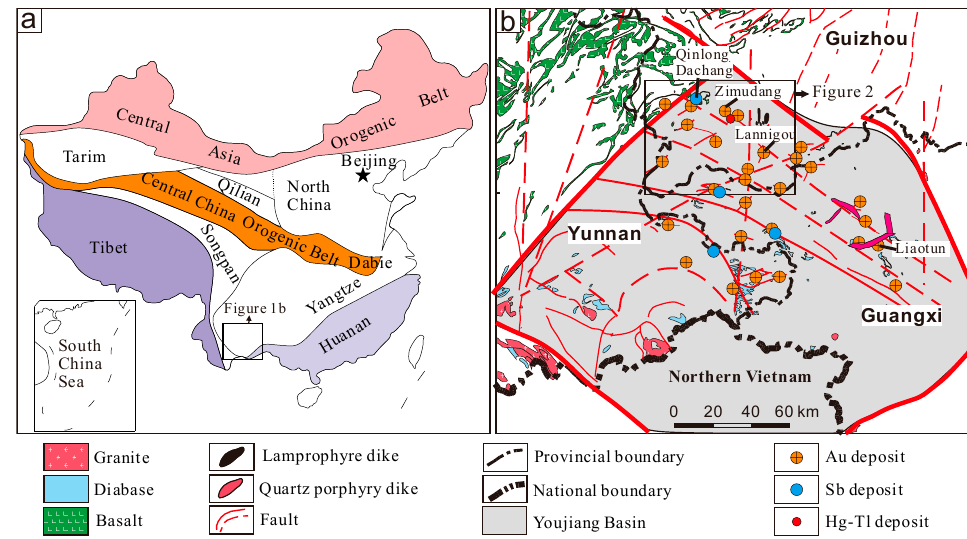
Figure 1. ( a ) Schematic tectonic map of China showing the location of the Youjiang Basin. ( b ) Geologic map of the Youjiang Basin showing the locations of the Carlin-type Au, Sb, and Hg-Tl deposits.